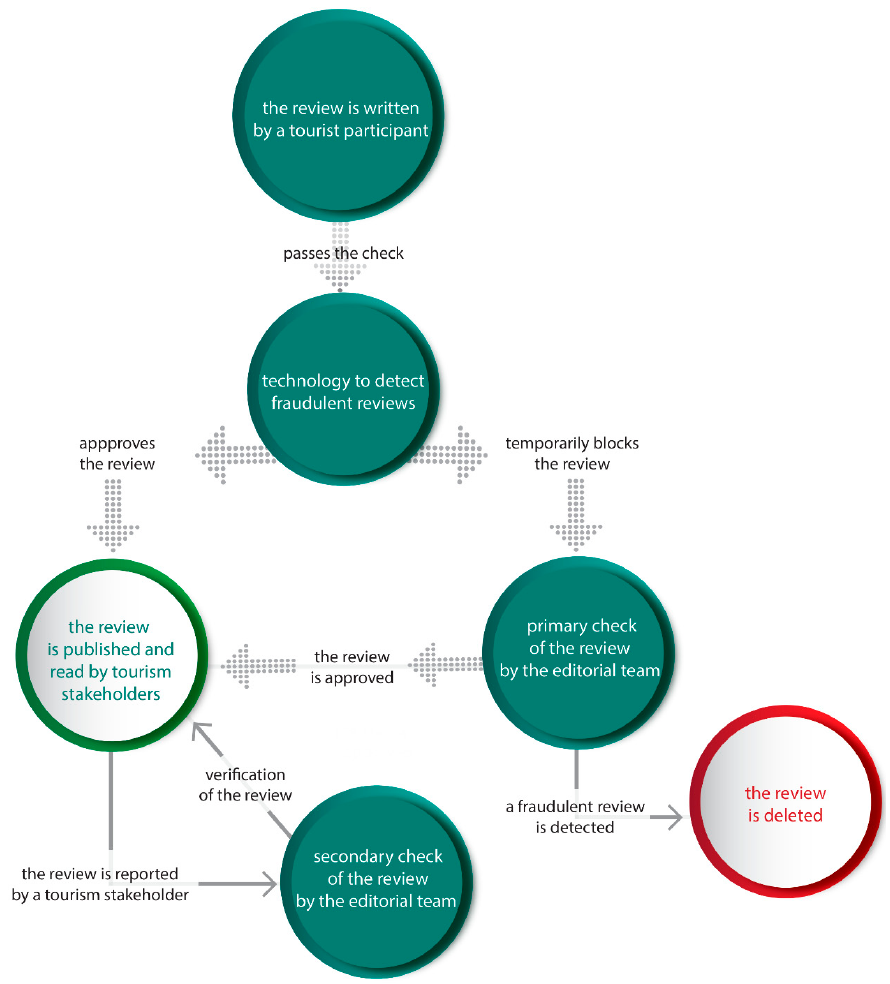
Figure 2. Review approval process on TripAdvisor. Source: TripAdvisor (2020b, 2020d).